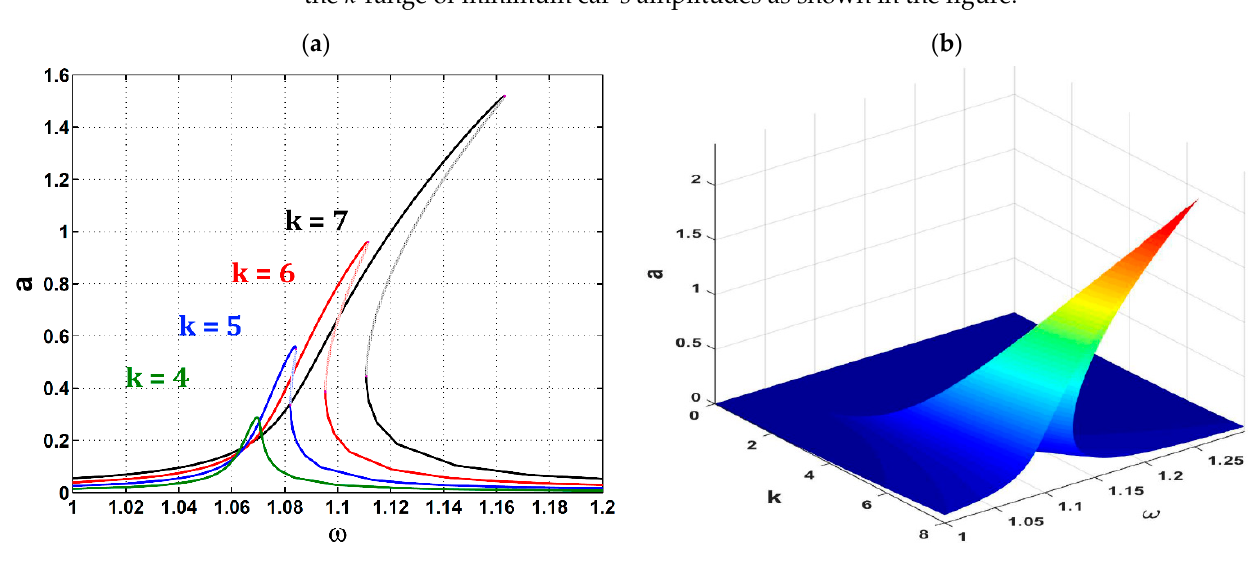
Figure 3. Relationship between the car’s oscillation amplitude a and ( a ) the excitation frequency ω at different values of excitation amplitude k , ( b ) both the excitation frequency ω and its amplitude k , at ζ = 0.02 and β = 0.8 pre-control ( k p = k v = 0).